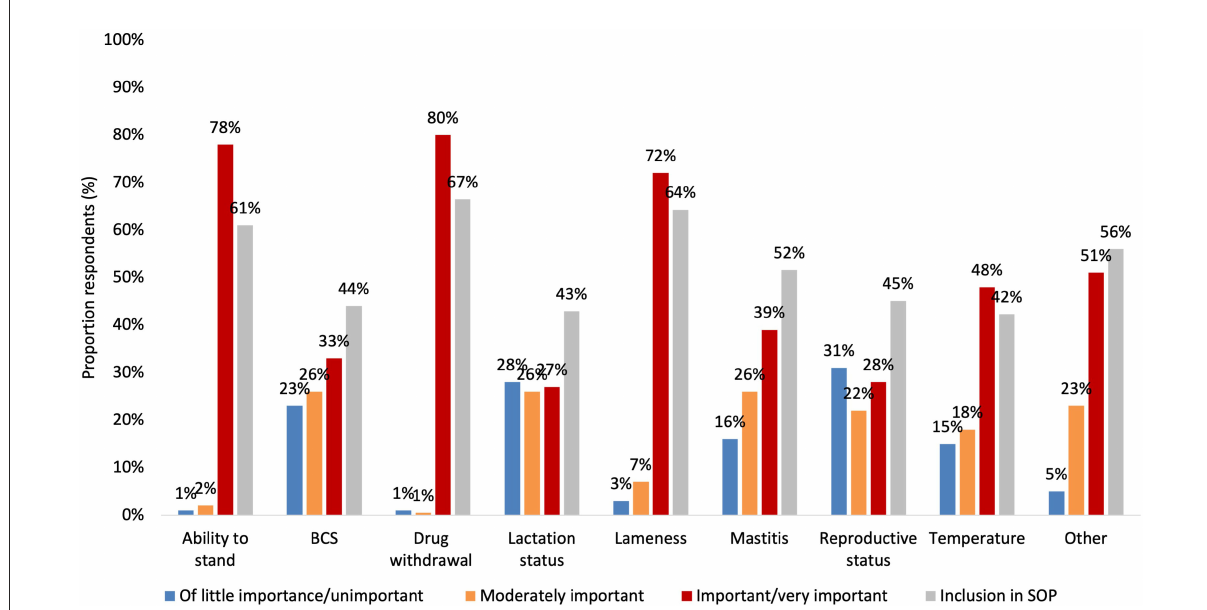
FIGURE2 Proportion of respondents ( n = 226) view on the importance (“very important/important,” moderately important,” “of little importance/unimportant”) of factors (blogs/online forums/LISTSERVS, extension personnel from OMAFRA, Lactanet (DHI), Dairy Farmers of Ontario (DFO), producer organizations other than DFO (e.g., OFA). Other producers, magazines/newsletters, scientific journals, social media (Facebook, Twitter, Instagram), researchers, your nutritionists or feed supplier, your veterinarian, websites/search engines (e.g., Google, Yahoo), and other) for obtaining information about cull cow